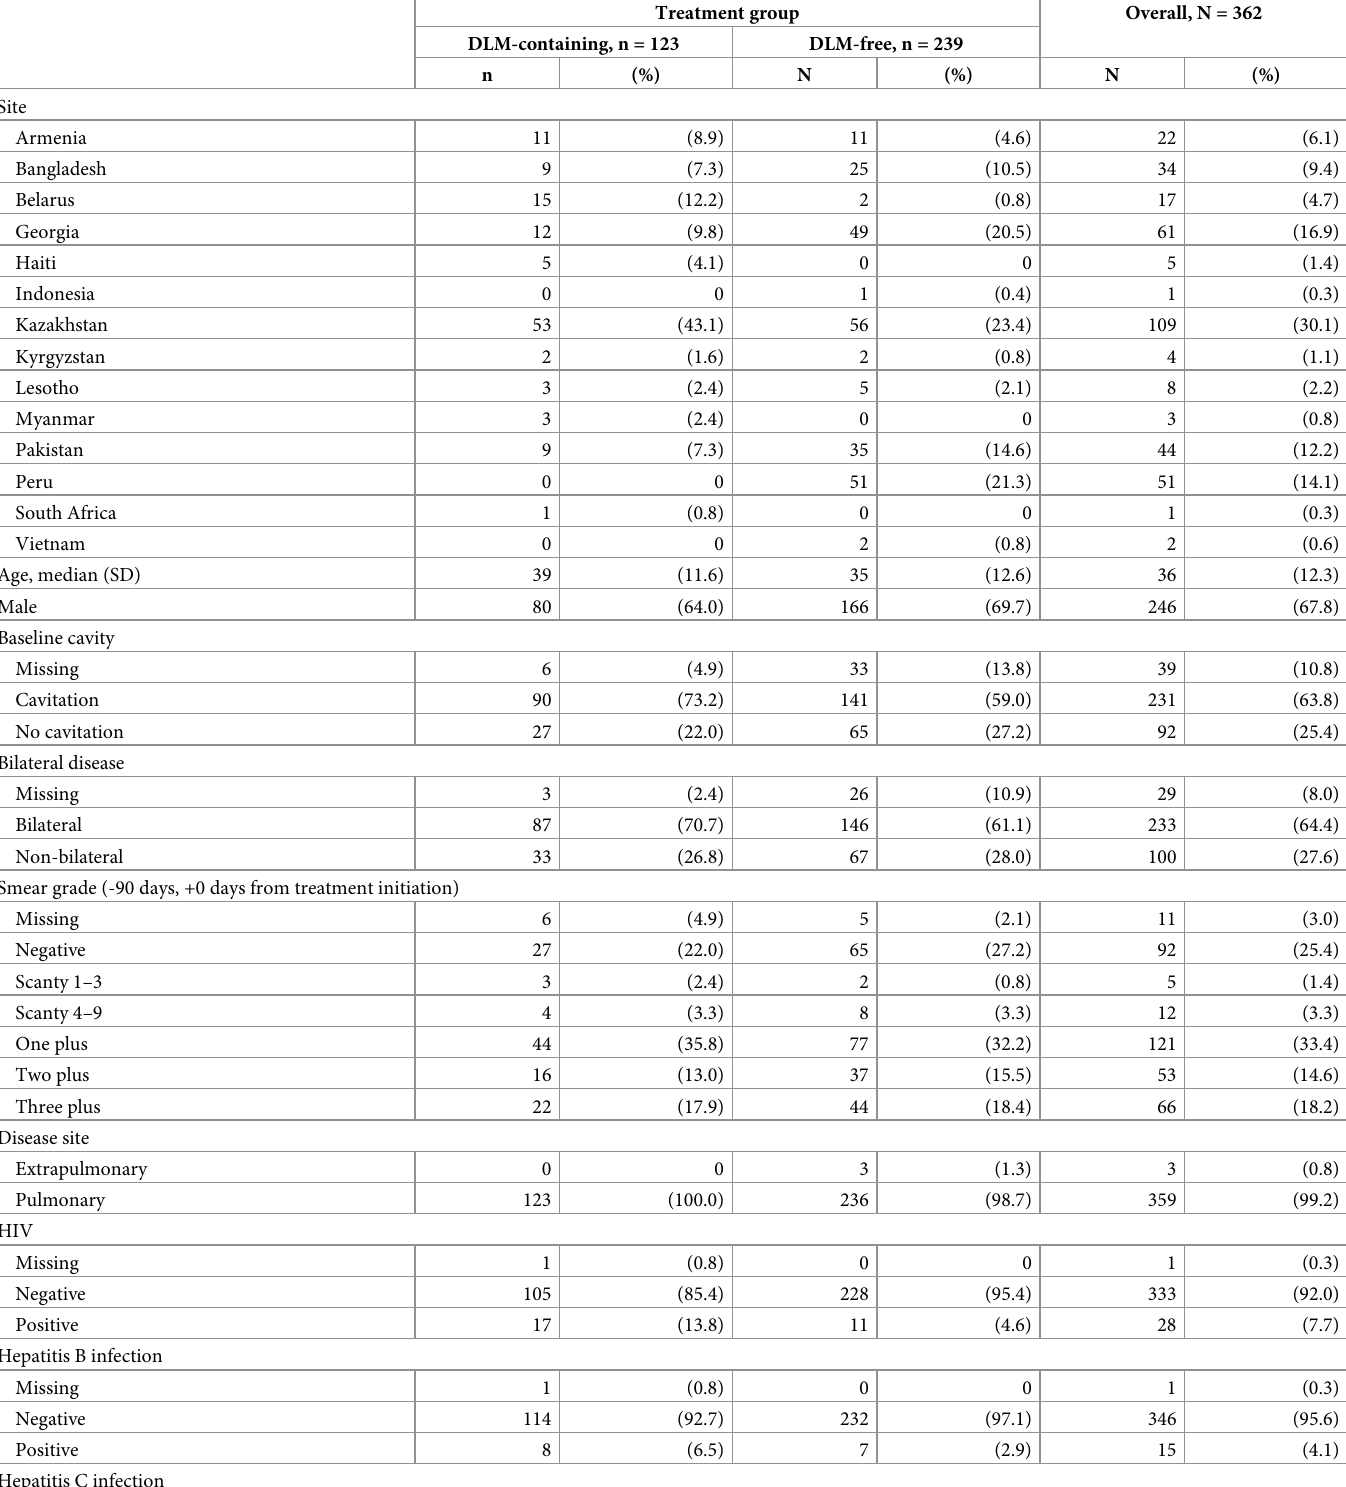
Table 1. Baseline characteristics of participants receiving three drugs likely to be effective +/- delamanid, endTB observational cohort (N =